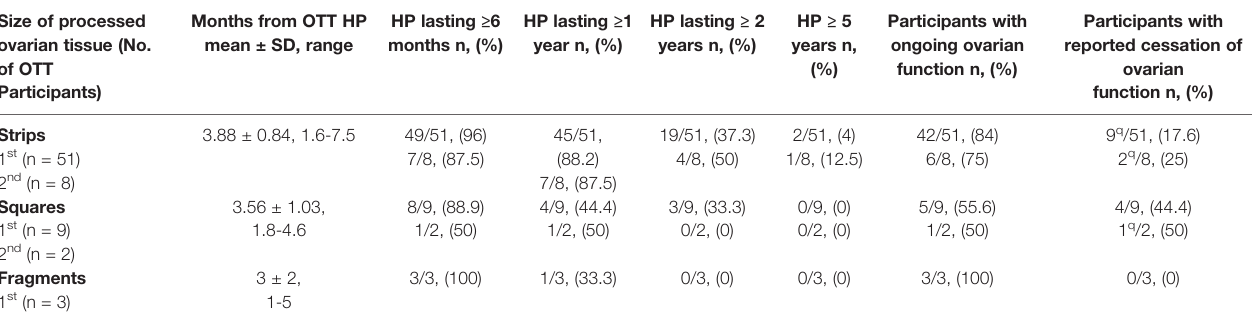
TABLE 5 | Ovarian function outcome after transplantation. Size of processed ovarian tissue (No.